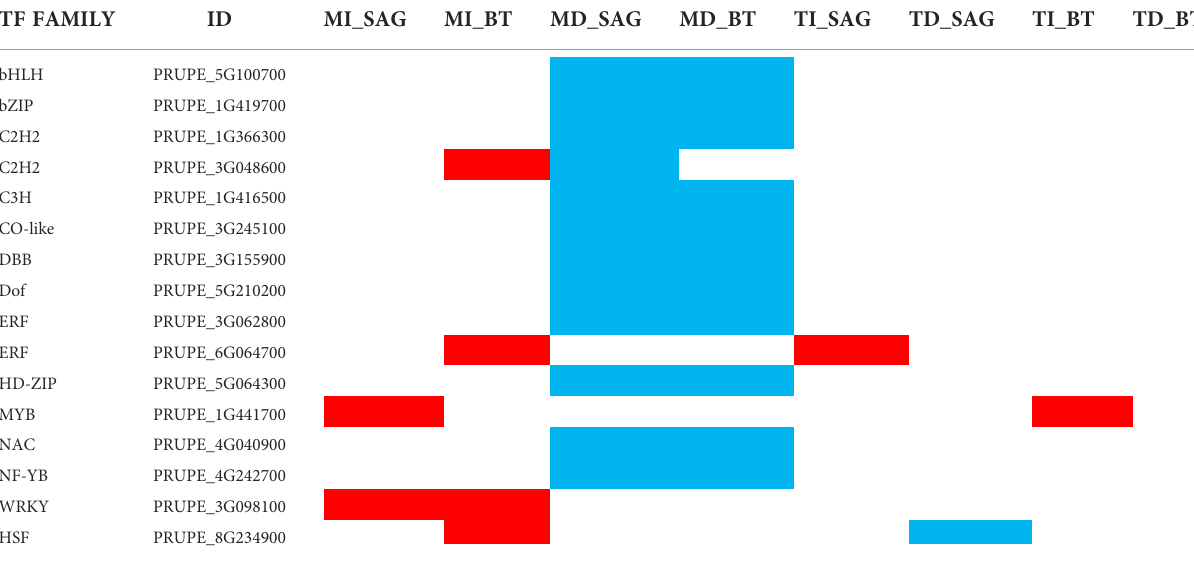
TABLE 6 Expression pattern of TF genes that are found in the MI or MD clusters in at least one cultivar.